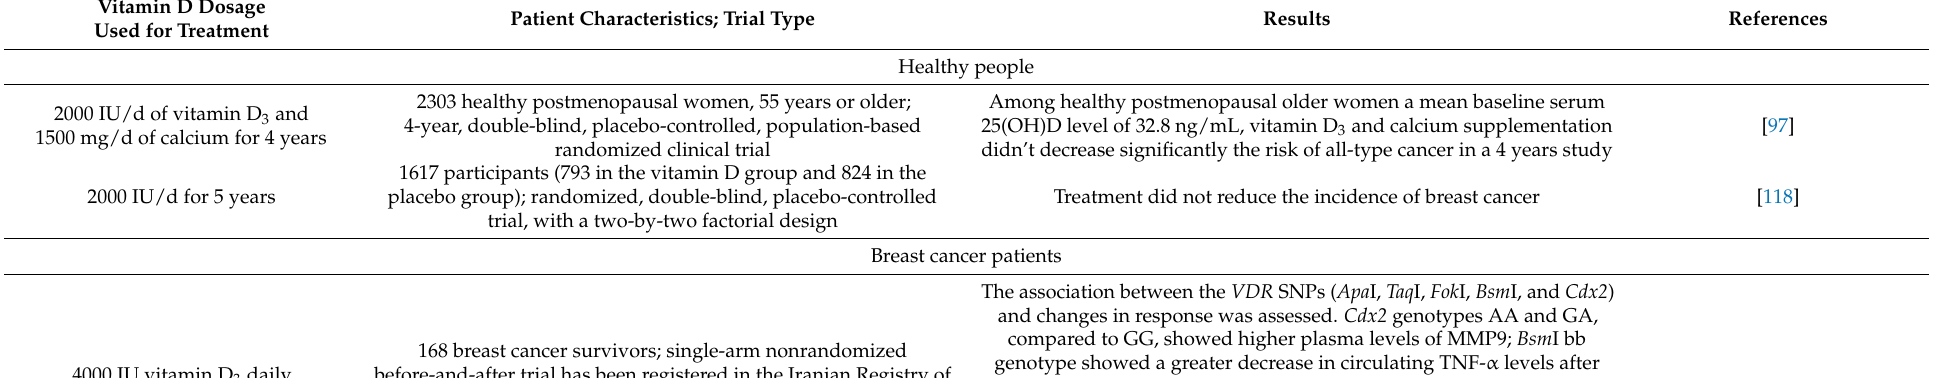
Table 2. Interventional studies in breast cancer patients and healthy